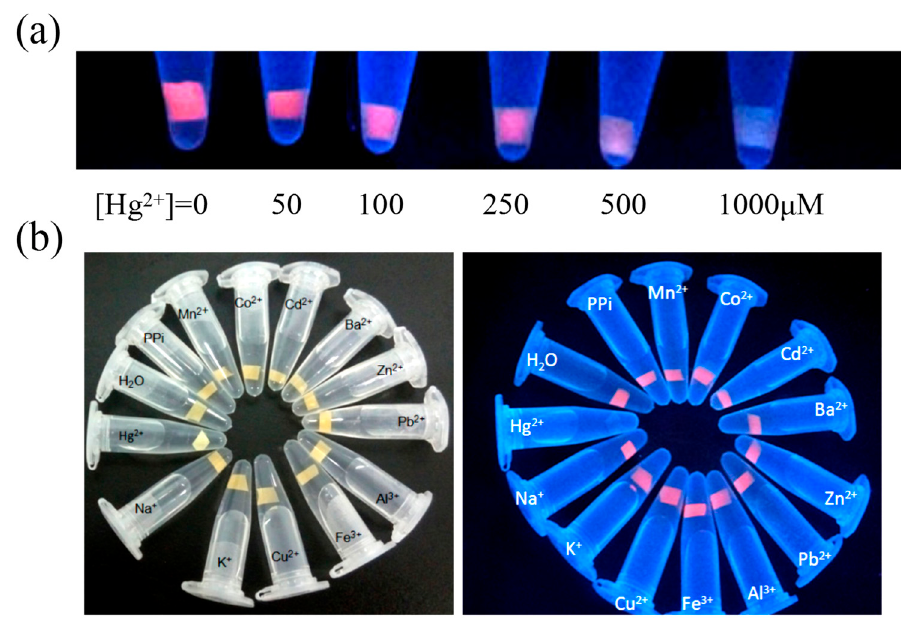
Figure 7. Monolithic Cu NCs@ESM as Hg 2+ sensing strips. ( a ) Visual detection of Hg 2+ ions photographed by daily used mobile phone at 30 min under 365 nm UV light; ( b ) Specificity test of Cu NCs@ESM strips against various other ions with the concentration of 500 µ M (PPi refers to pyrophosphate ions). Photos were taken at 1 h under sunlight (left) and 365 nm UV light (right), respectively.